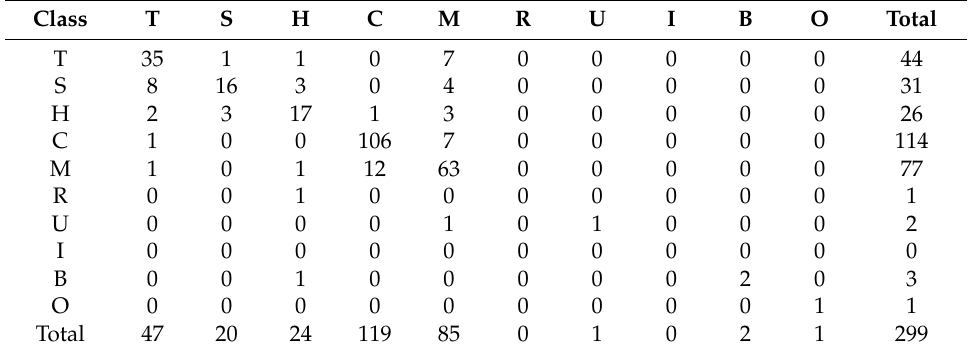
Table 4. Confusion matrix for the classification of Scenario 4c; columns show the class label in the reference data set and rows the label determined in the